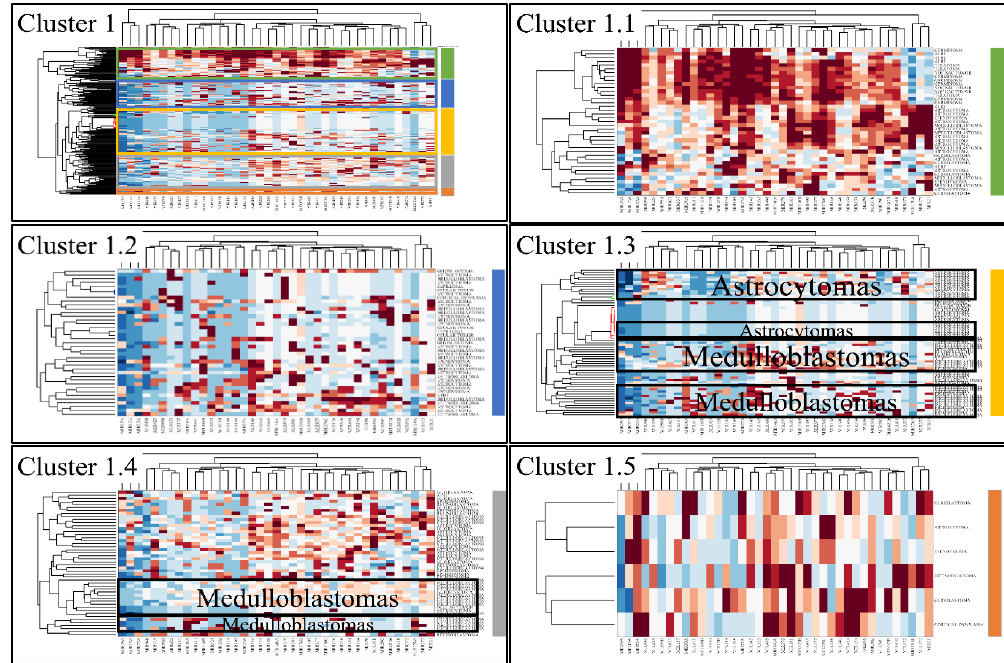
Figure 3. Unsupervised k-means clustering of DE miRNAs. Clustering resulted in four clusters ( A ), which are presented with their centroids ( B ) and the respective sorted centroids ( C ).